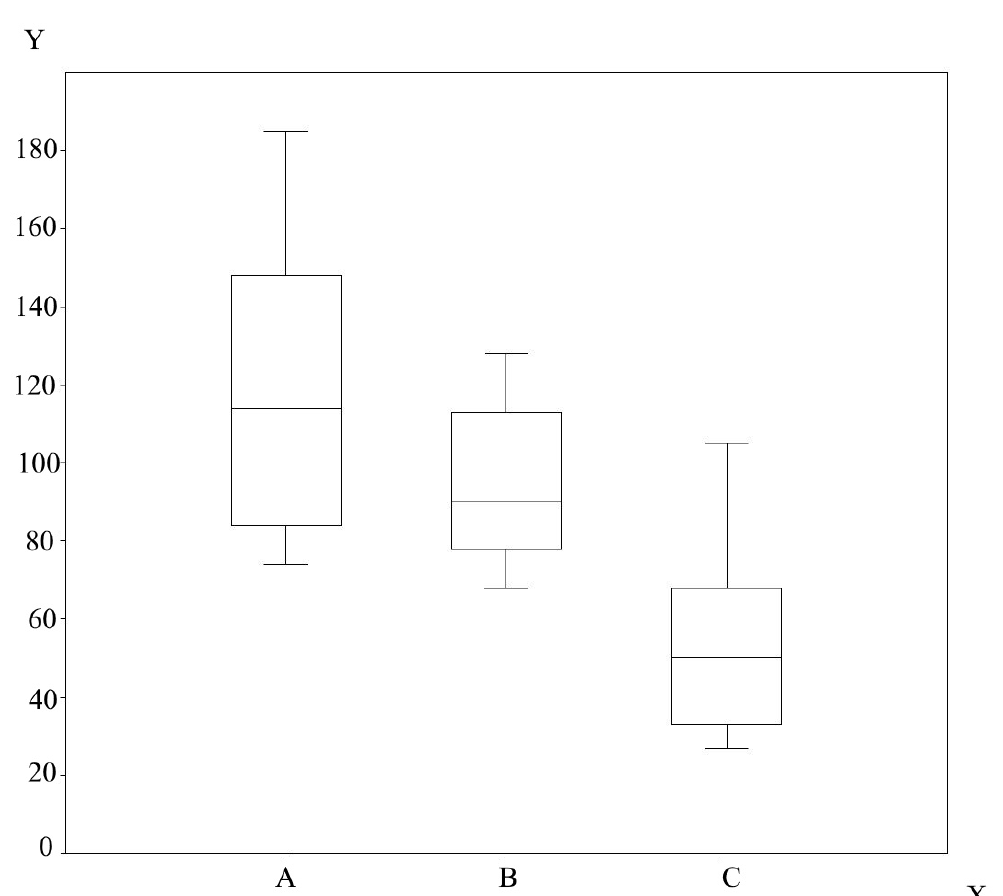
Figure 14. Boxplots of the lengths and widths of the cobble tools. Dimensions provided in Supplementary File 1.